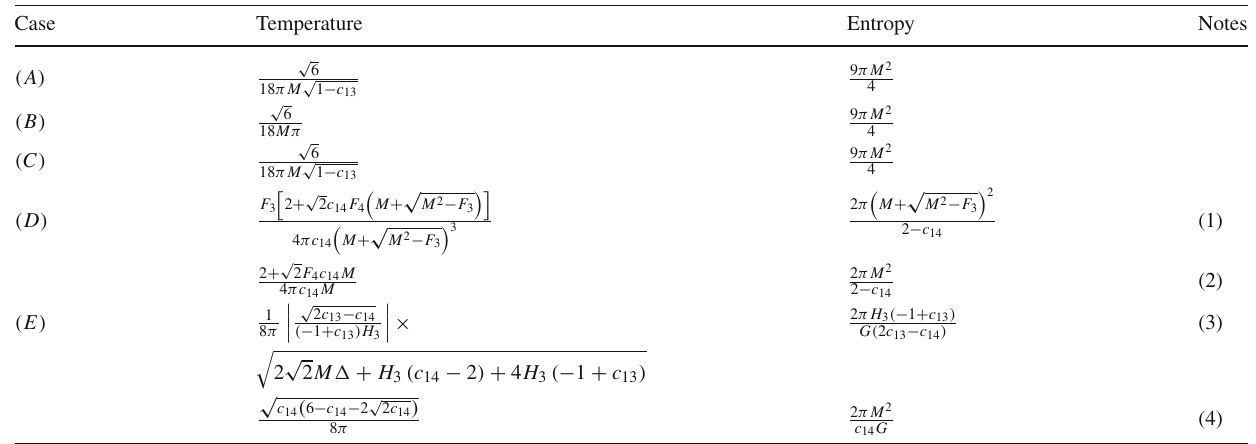
Table 3 Summary of the temperature and entropy